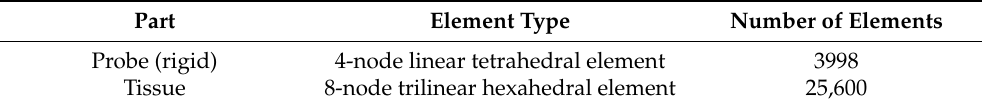
Table 2. Elements in FEBio simulation.